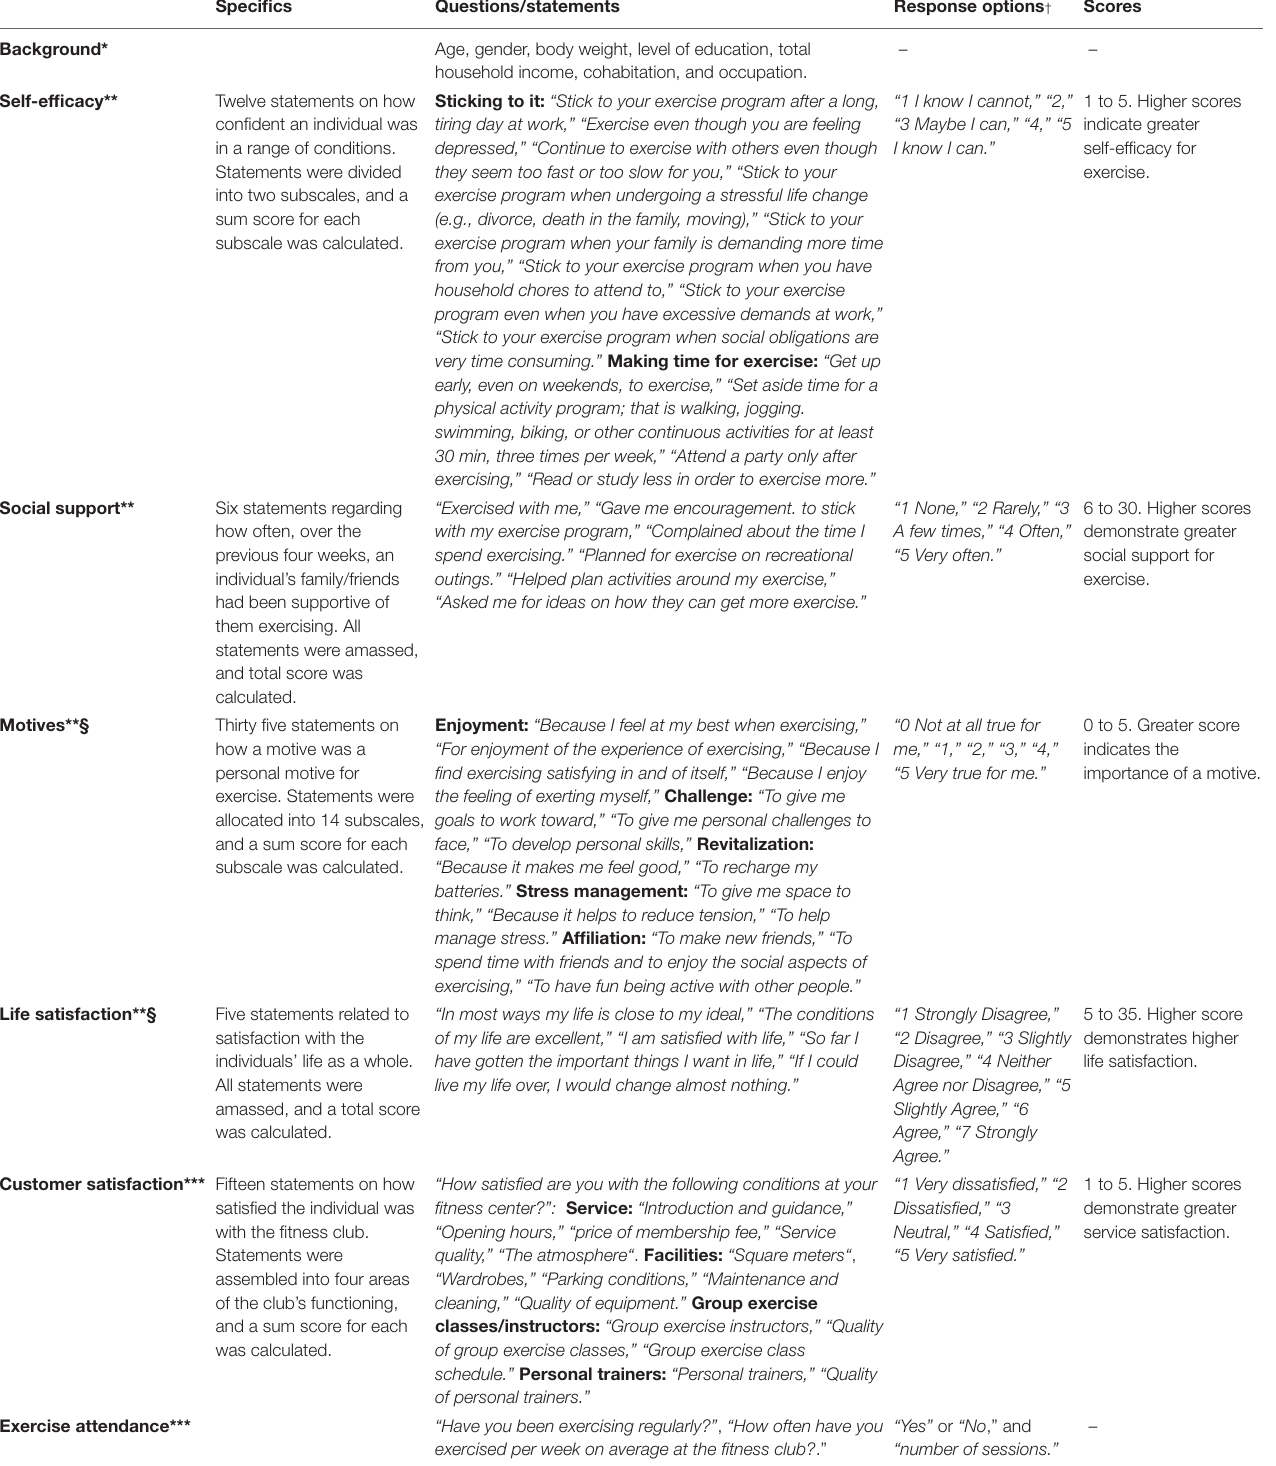
TABLE 1 | Psychosocial factors and customer